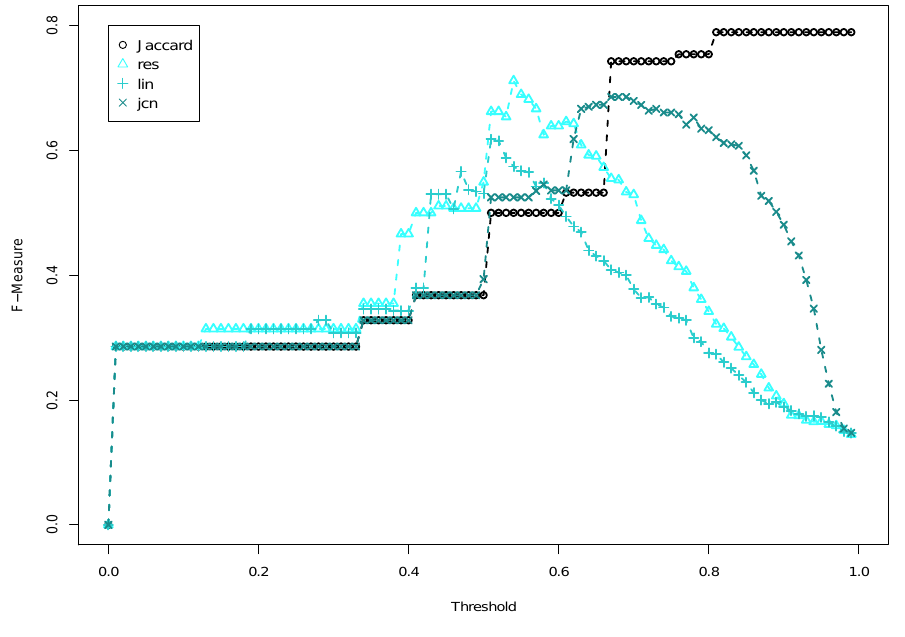
Figure 4. Semantic dissimilarity evaluation using word similarities derived from WordNet, based on an information content approach.